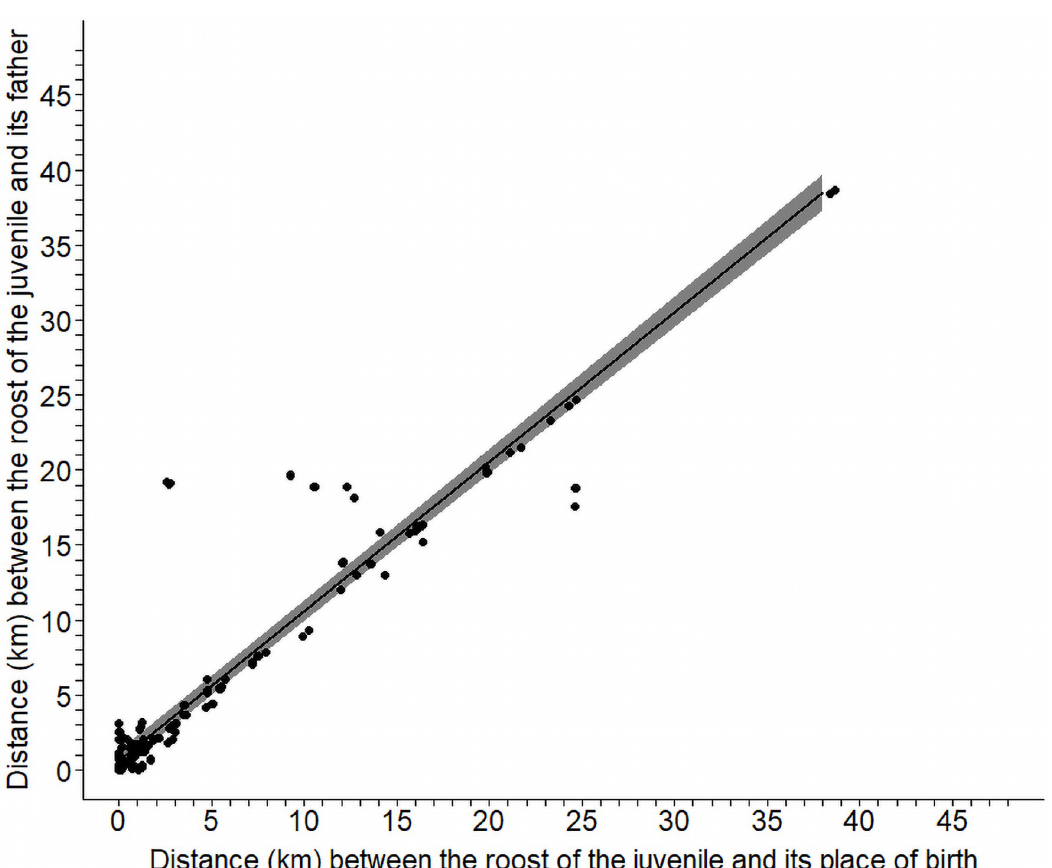
Fig 6. Distance between the roost of the juvenile and its father in relation to the distance between the roost of the juvenile and its place of birth. Shown are raw data (squares) and the fitted line with 95%CrI of a linear-mixed effect model with ‘Distance between the roost of the juvenile and its father’ as dependent variable, ‘distance between the roost of the juvenile and its place of birth’ as explanatory variable and juvenile identity nested in family as random effect. The analysis is based on 542 observations of 23 juveniles from 12 broods in 2005.